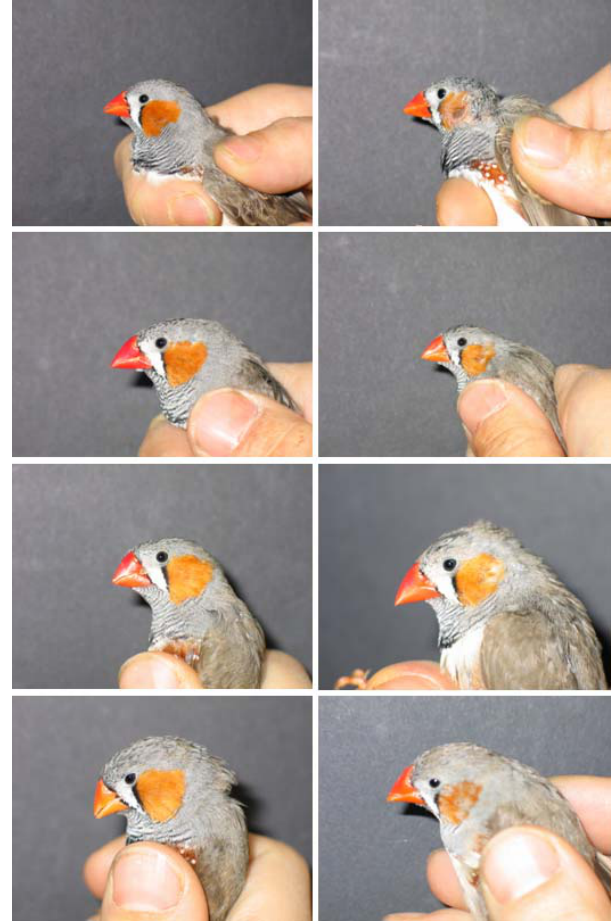
Figure 3. Pictures taken at day 60 from sibling juvenile males (in rows) that had experienced different nutritional conditions (left: high quality food; right: standard food) from day 35 until day 60, i.e. immediately after nutritional dependence from the parents.